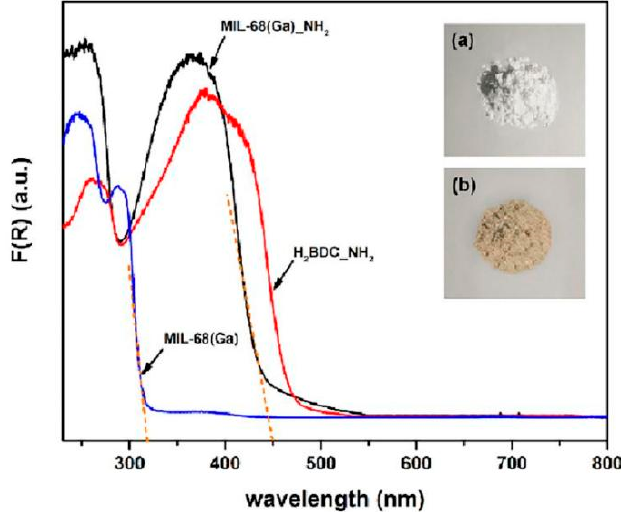
Figure 3. UV-vis DRS of MIL-68(Ga)_NH 2 (black), MIL-68(Ga) (blue) and H 2 BDC_NH 2 (red). The insets are the photographs of ( a ) MIL-68(Ga) and ( b ) MIL-68(Ga)_NH 2